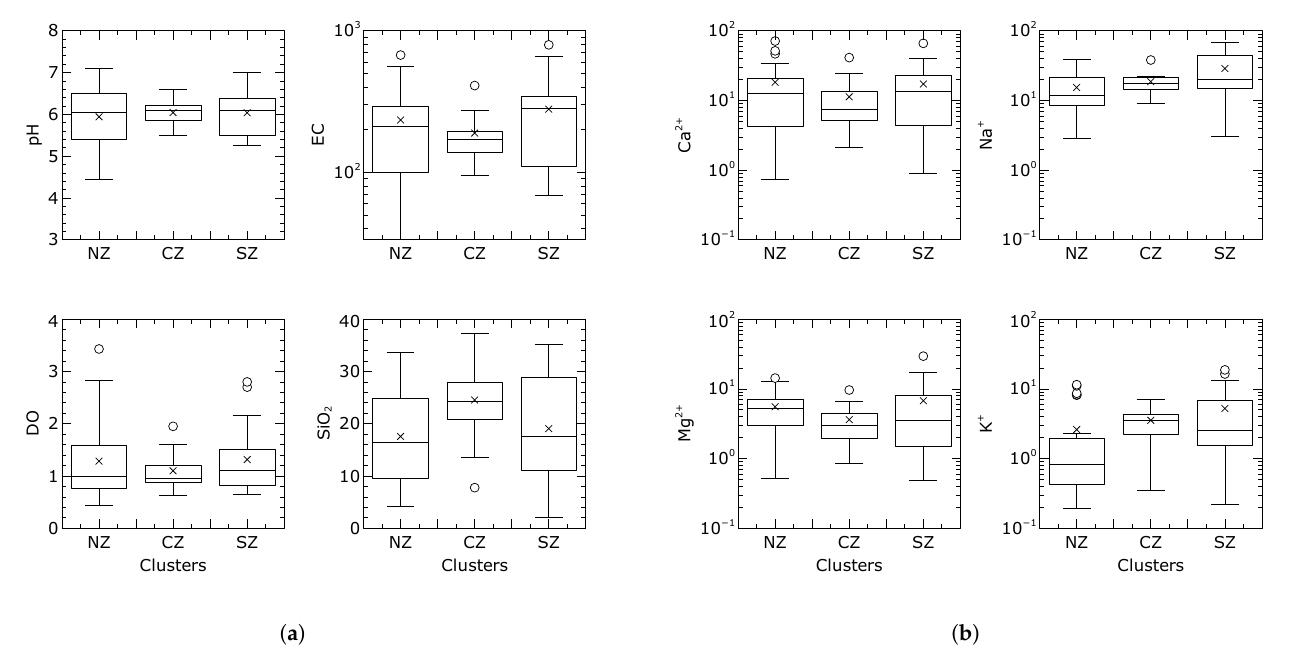
Figure 8. Box-and-whisker plots displaying the variations in the ( a ) physical parameters and silica content, and ( b ) major cations in the groundwater. The interpretation of the box-and-whisker plots follows the legend presented in Figure 3. The horizontal solid line and the x symbol on the box-and- whisker plot represents the average and the median concentrations, respectively. Outliers are defined by points that fall more than 1.5*IQR above the third quartile or below the first quartile. NZ, CZ and SZ denote the northern zone, central zone and southern zone, respectively. All chemical parameters are measured in mg/L except for pH and EC µ S/cm.